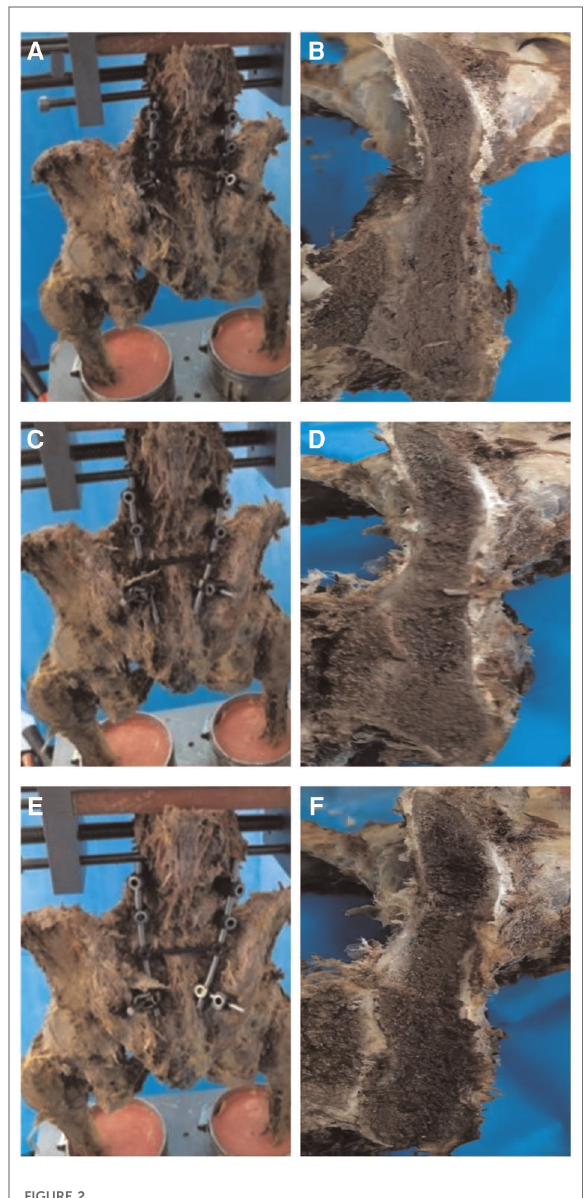
FIGURE 2 ( A ) Placed iliac screw from PSIS to AIIS. ( B ) Cross-sectional view of the channel from PSIS to AIIS. ( C ) Placed iliac screw from 1 cm medial and 1 cm caudal of PSIS to AIIS. ( D ) Cross-sectional view of the channel from 1 cm medial and 1 cm caudal of PSIS to AIIS. ( E ) Placed iliac screw from 2 cm below PSIS to AIIS. ( F ) Cross- sectional view of the channel from 2 cm below PSIS to